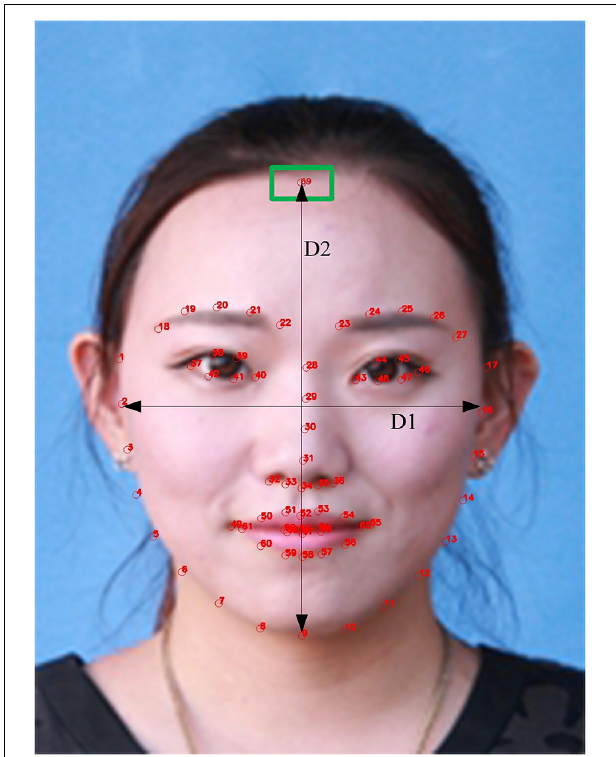
FIGURE 8 | D1/D2 is the transverse/longitudinal ratio of face. The green rectangle marks the point of the hairline after adding hairline detector (Clarification: written informed consent was obtained from the individual for the publication of this